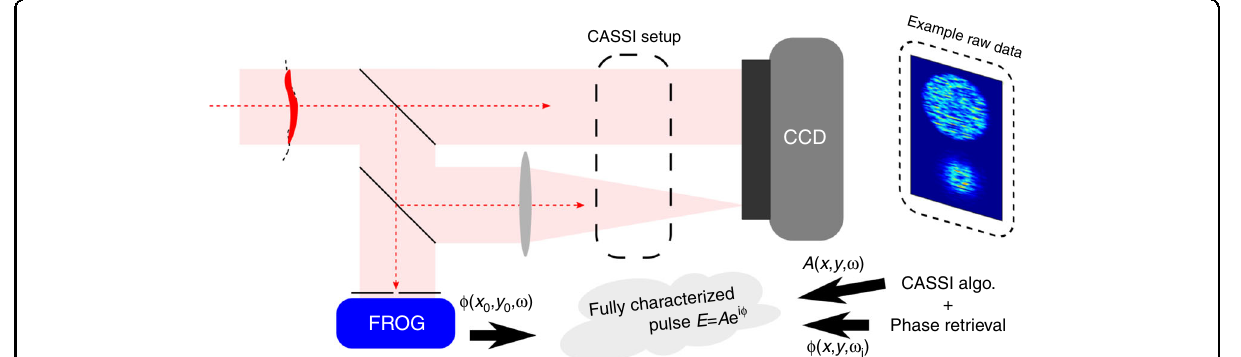
Fig. 1 Basic layout of the COFT system and how it works. See the text for more